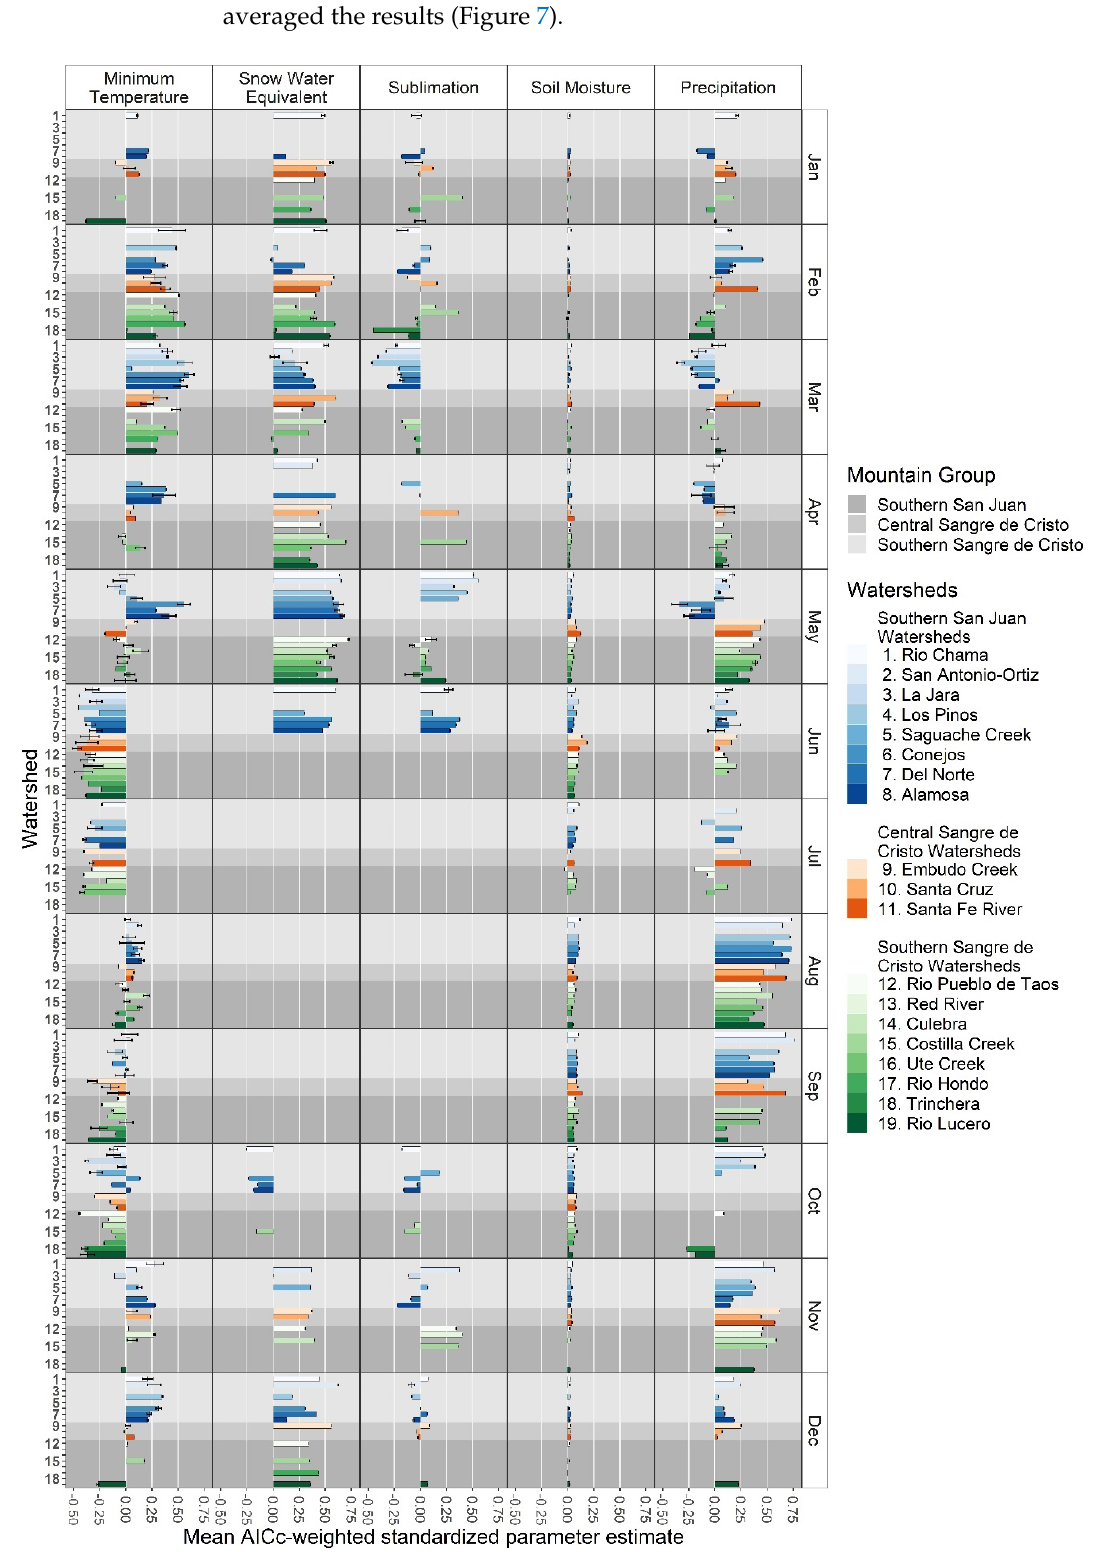
Figure 7. AICc-weighted standardized parameter estimates, adjusted with intercept-only models. There are several combinations of months and basins where SWE and sublimation are omitted because they have too many zeros. Therefore, the permutations of the rank- ings are excluded when SWE or sublimation was the top variable. Some parameter